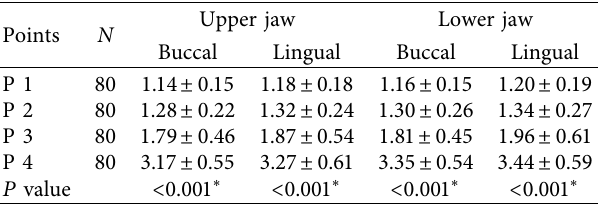
Figure 1: (a) Horizontal line: a line was drawn horizontally from the buccal to palatal/lingual surfaces at the location of the ridges. (b) Bone thickness of buccal and palatal/lingual walls was measured vertically to the root in dentate regions through coronal view at four points: crestal bone thickness (P1), midroot bone thickness (P2), middle of the alveolar bone housing (P3), and apical portion of the tooth bone thickness (P4). (c) Alveolar ridge thickness in edentulous regions at three points: crestal ridge thickness (EP1), second point 5 mm from crestal (EP2), and third point 10mm from crestal (EP3). Table 2: Bone thickness (mm) at 4 points of dentate sites on buccal and lingual sides according to the site (upper or lower